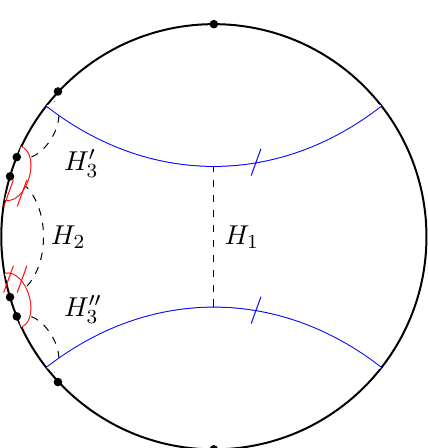
Figure 3. A Cauchy slice of the three-boundary black hole shown as a quotient of AdS 3 . The action of γ identifies the two blue geodesics while γ 1 horizons of the three boundaries H coincide with the geodesic connecting the fixed points of the isometries γ Note that γ has four fixed points instead of two, because it defines the third asymptotic region as 3 the union of two separate regions in the Cauchy slice. In the case of no rotation, this slice is that of t = 0